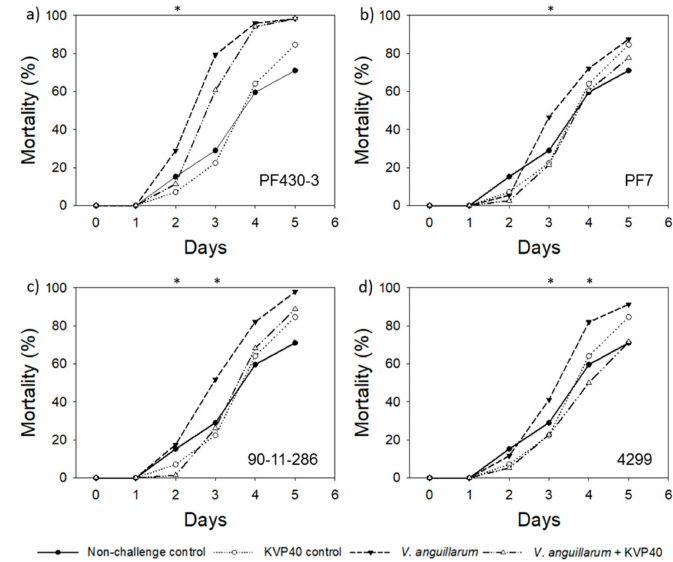
Figure 2. Cumulative percent mortality over time in turbot challenge trial 2: ( a ) strain PF430-3; ( b ) strain PF7; ( c ) strain 90-11-286; ( d ) strain 4299. Significant difference in mortality between cultures “ V. anguillarum ” and “ V. anguillarum + KVP40” for individual time points is indicated by